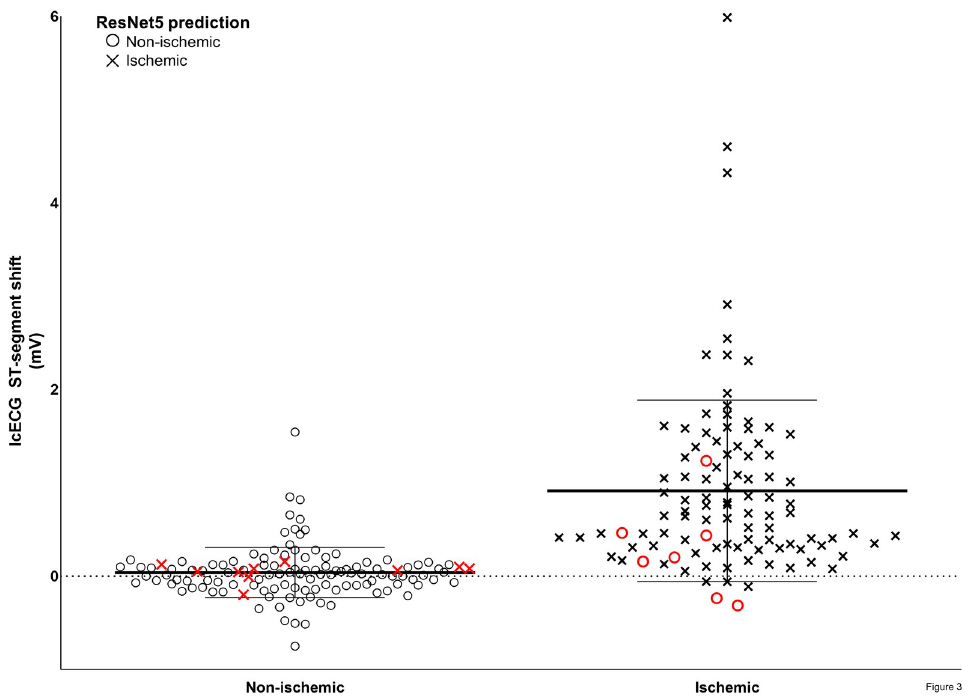
Fig 3. IcECG ST–segment shift grouped according to the state of absent or present coronary artery balloon occlusion. Combination of the validation and the examination data (n = 225) was used for the performance analysis. Black circles: Non–ischemic prediction of ResNet5, black crosses: Ischemic prediction of ResNet5. Red signals: wrong predictions of ResNet5. Error bars indicate mean values and SD.